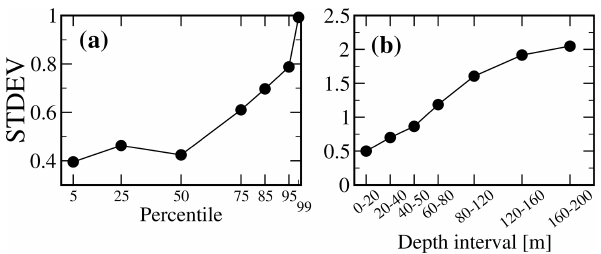
Figure 8. (a) Intermodel standard deviation calculated from the 5th, 25th, 50th, 75th, 85th, 95th, and 99th percentile surface tempera- tures. The percentiles represent area averages over the whole Baltic Sea. (b) Intermodel standard deviation of depth-interval-averaged water temperature. Standard deviations are calculated from spatial averages over the whole Baltic Sea from each of the six models. The analysis covered the period of